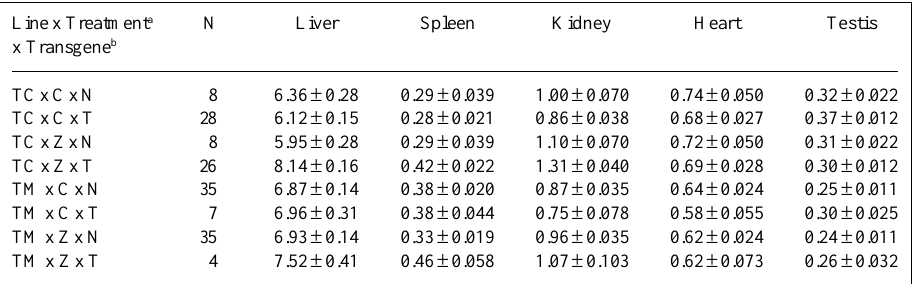
Table VI - Least-squares means ± SE for line by treatment by transgene subclasses within lines TC and TM for organ weights as a percentage of 8-week body weight